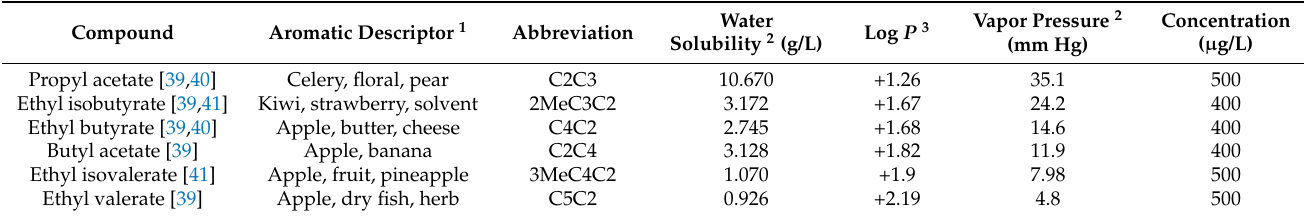
Table 2. Physicochemical properties of